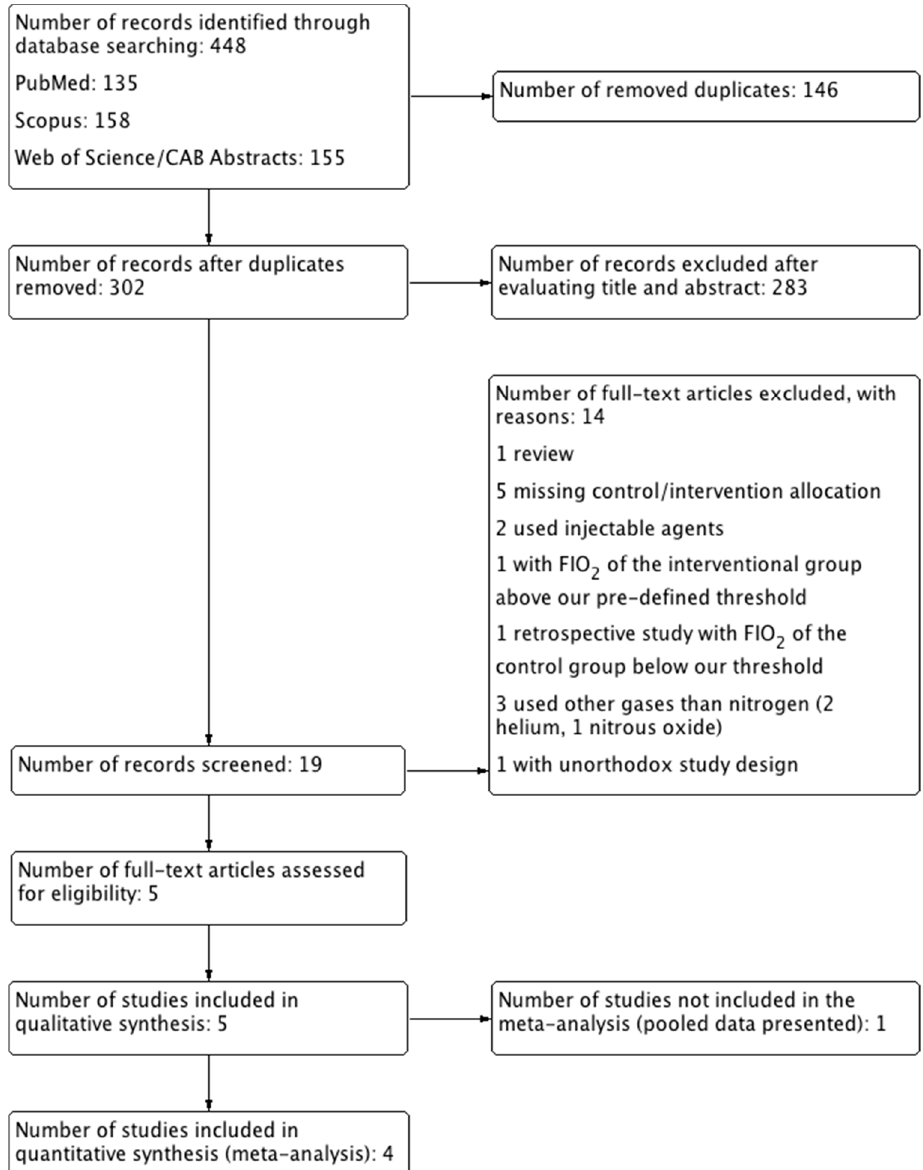
Figure 1. Study flow diagram.